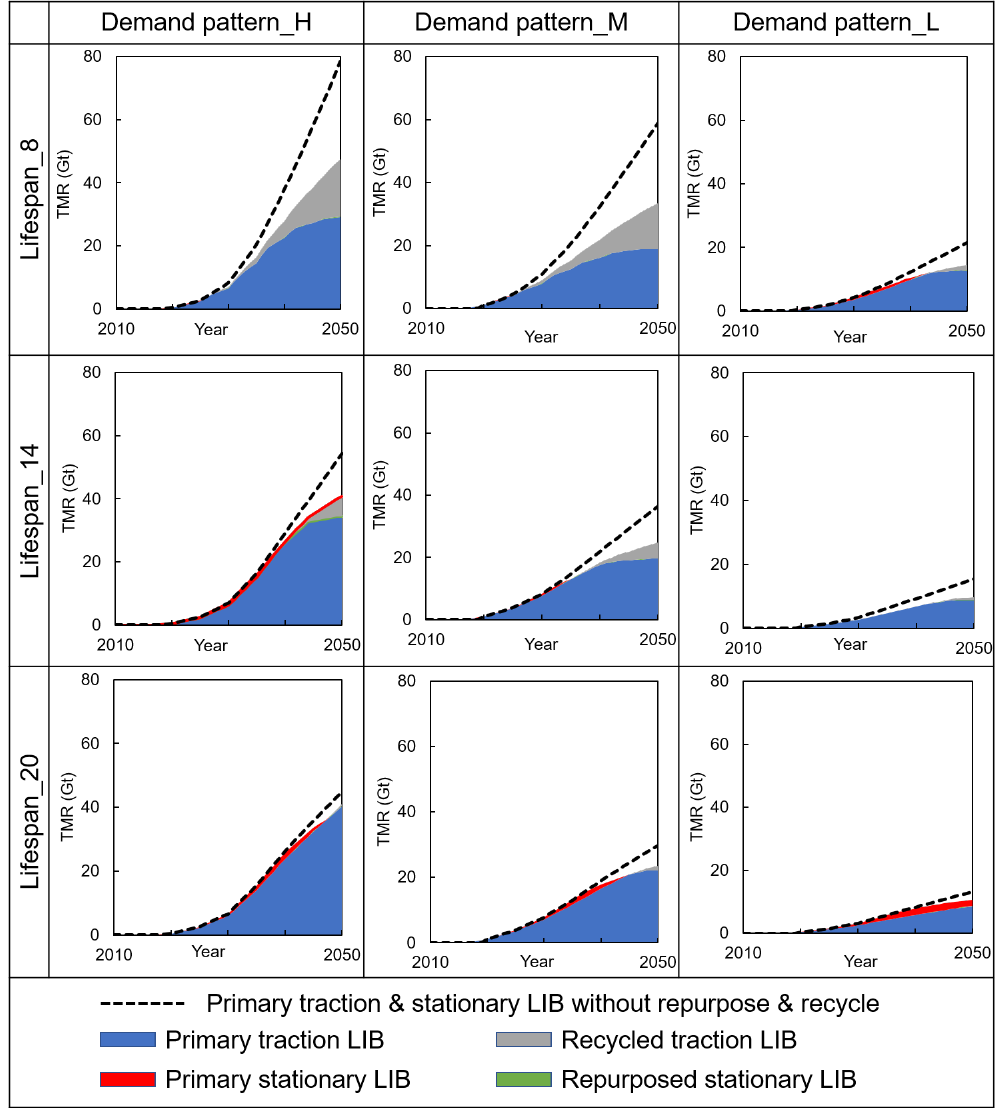
Figure 5. Global circular resource use for LIBs during the period from 2010 to 2050. Table 2. Reduction rate for global resource use for LIBs through circularity in 2050.